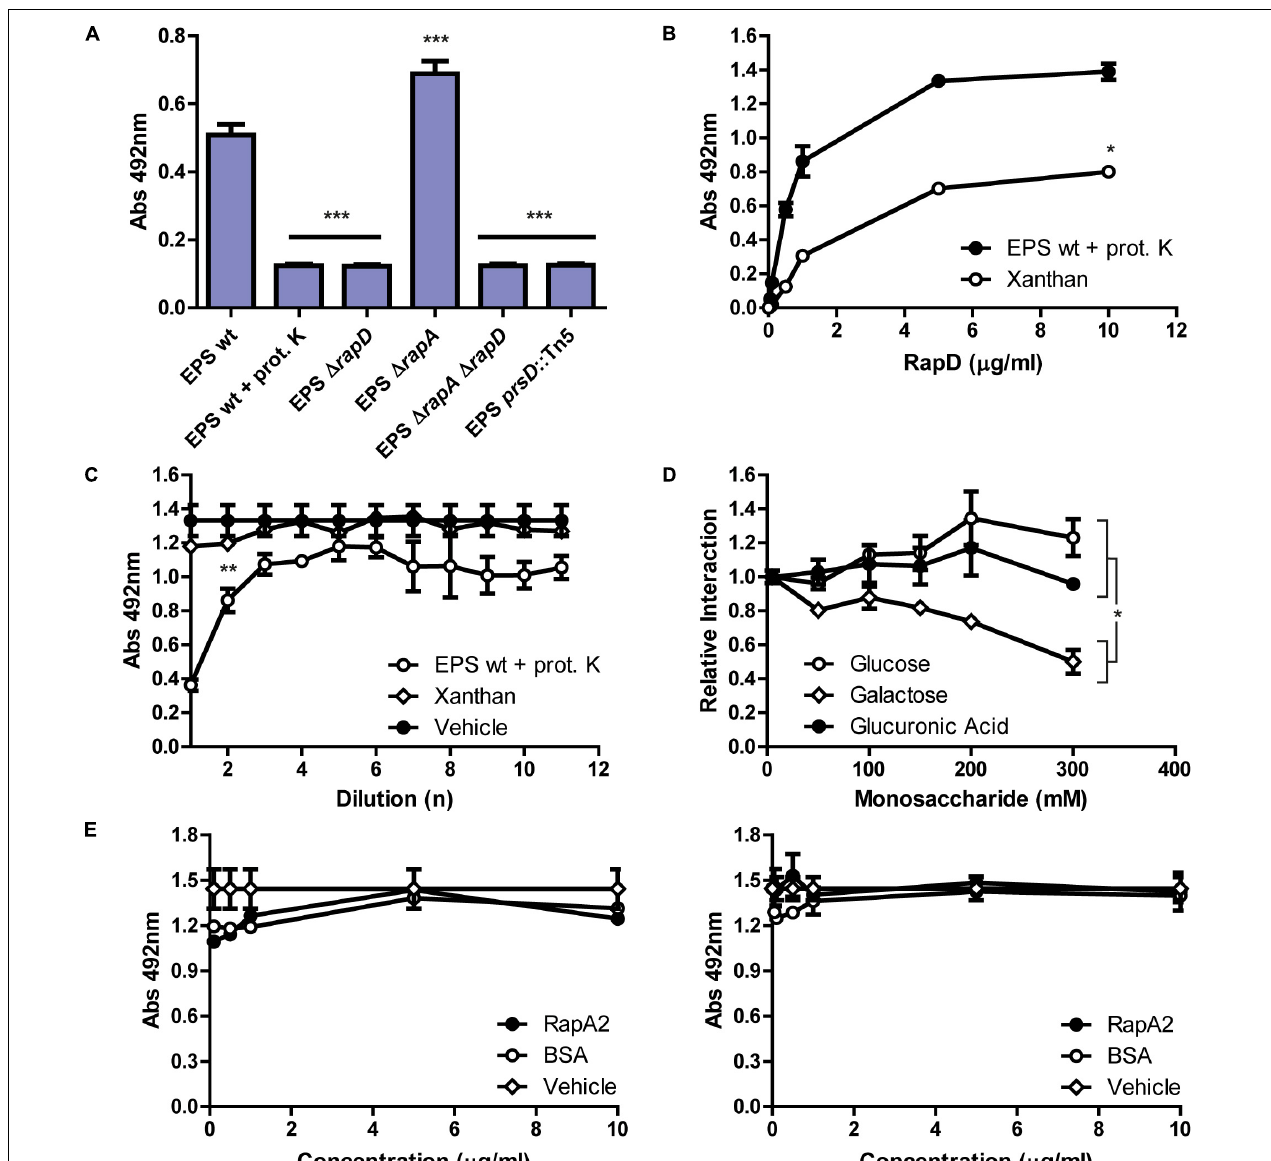
FIGURE 7 | Characterization of the interaction between RapD and the EPS of R. leguminosarum . (A) Immunodetection of the RapD-EPS interaction by ELISA assay. Crude EPS preparations (0.1 mg/ml) from 5-days-cultures grown in minimal media of several Rlv 3841 derived strains were analyzed. The EPSs were immobilized in an ELISA plate and endogenous RapD interaction was revealed using the mouse anti-RapD polyclonal antiserum and an anti-mouse HRP conjugated secondary antibody (Jackson). A representative experiment of 2 independent replicas measured in triplicate is shown. Asterisks indicate statistical differences with the wild type EPS analyzed by one-way ANOVA with an α of 0.05; p < 0.0001. (B) ELISA assay. Kinetics of the binding of RapD to immobilized proteinase-treated-EPS or Xanthan in the presence of 1 mM CaCl 2 , and revealed using anti-RapD antiserum. 50% binding for RapD-EPS was achieved at 0.5 µ g/ml and at 1 µ g/ml for RapD-Xanthan. Shown is a representative experiment of three independent experiments measured in triplicate each. An asterisk indicates statistical differences between both polysaccharides analyzed by paired t -test with an α of 0.05; p < 0.05. (C) Binding inhibition assay (BIA) using diluted Xanthan or proteinase K treated-EPS as competitors in the presence of calcium. The inhibition of the RapD-binding to the immobilized proteinase K treated-EPS was evaluated by preincubating the protein with different concentrations of EPS, Xanthan, or vehicle. Shown in the X-axis are the 10-fold dilutions of each respective competitor starting from 0.1 mg/ml. Asterisks indicate statistical differences between the 3 treatments at a 100-fold dilution of the inhibitory compound analyzed by one-way ANOVA with an α of 0.05 using Tukey post-test; p < 0.005. (D) RapD-EPS binding dynamics analyzed by BIA: monosaccharide competition. Binding inhibition assay preincubating recombinant RapD with increasing concentrations of glucose, galactose, or glucuronic acid ranging from 0 to 300 mM before exposure to fixed proteinase K treated-EPS. A representative experiment of three independent replicas measured in duplicate is shown. An asterisk indicates statistical differences between galactose and glucose or glucuronic acid at 300 mM analyzed by one-way ANOVA with an α of 0.05 and Tukey post-test; p < 0.05. (E) Competition between RapD and RapA2 for the binding to the EPS. The Rhizobium -EPS was pre-incubated with RapA2, BSA (0–10 µ g/ml) or buffer (vehicle) before addition of RapD (5 µ g/ml) (left). EPS was incubated at the same time with RapD (5 µ g/ml) and increasing concentrations of RapA2 or BSA (0–10 µ g/ml) (right).